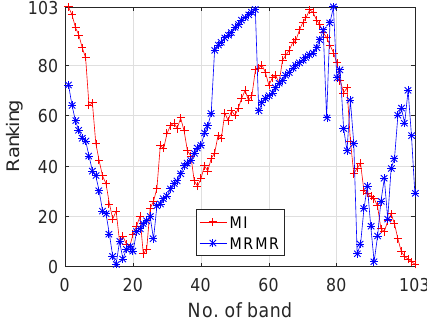
Figure 8. Ranking of each band using MI (red+ line) and MRMR (blue* line), where the x-axis is the band number and y-axis denotes the ranking where smaller value means higher